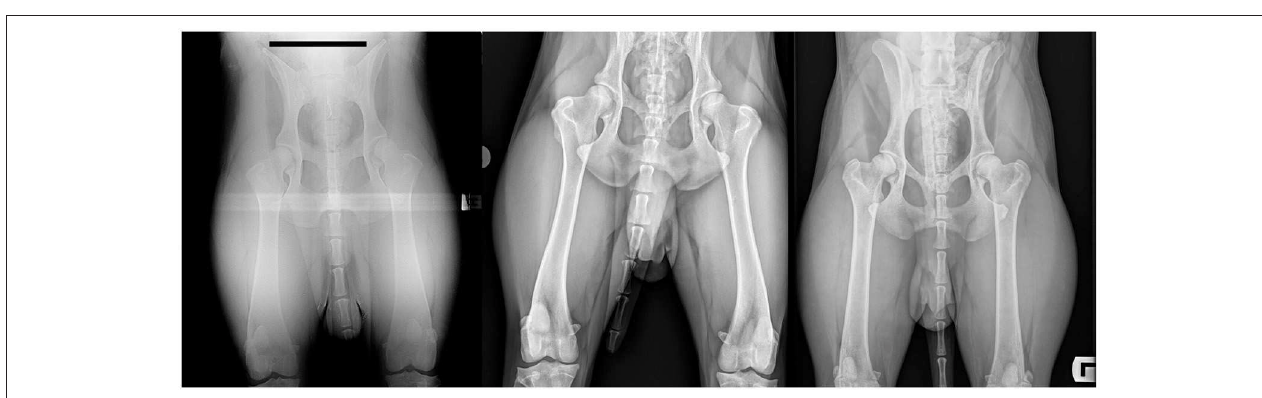
FIGURE 3 | Test images selected according to VGA results, and the reference image. The relatively low quality image (left) has an overall VGA value of − 1.7. It thus lies on the spectrum between being worse ( − 1) and much worse ( − 2) than the reference image. The relatively high quality image (right) has an overall VGA value of + 0.5. It thus lies on the spectrum between being similar to and better than, the reference image. The reference image is shown in the center. The assessment criteria called on the observers to focus attention on the region of the mid-diaphysis of the right femur and on the right hip/femoral trochanter region. Images have